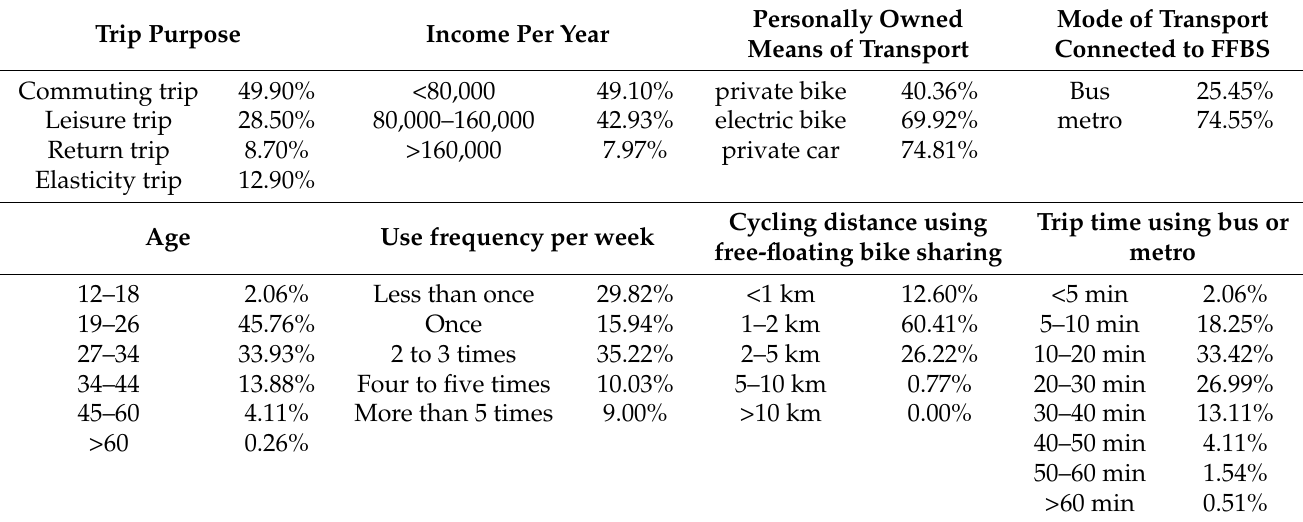
Table 4. Demographics and usage characteristics of sample for Pattern